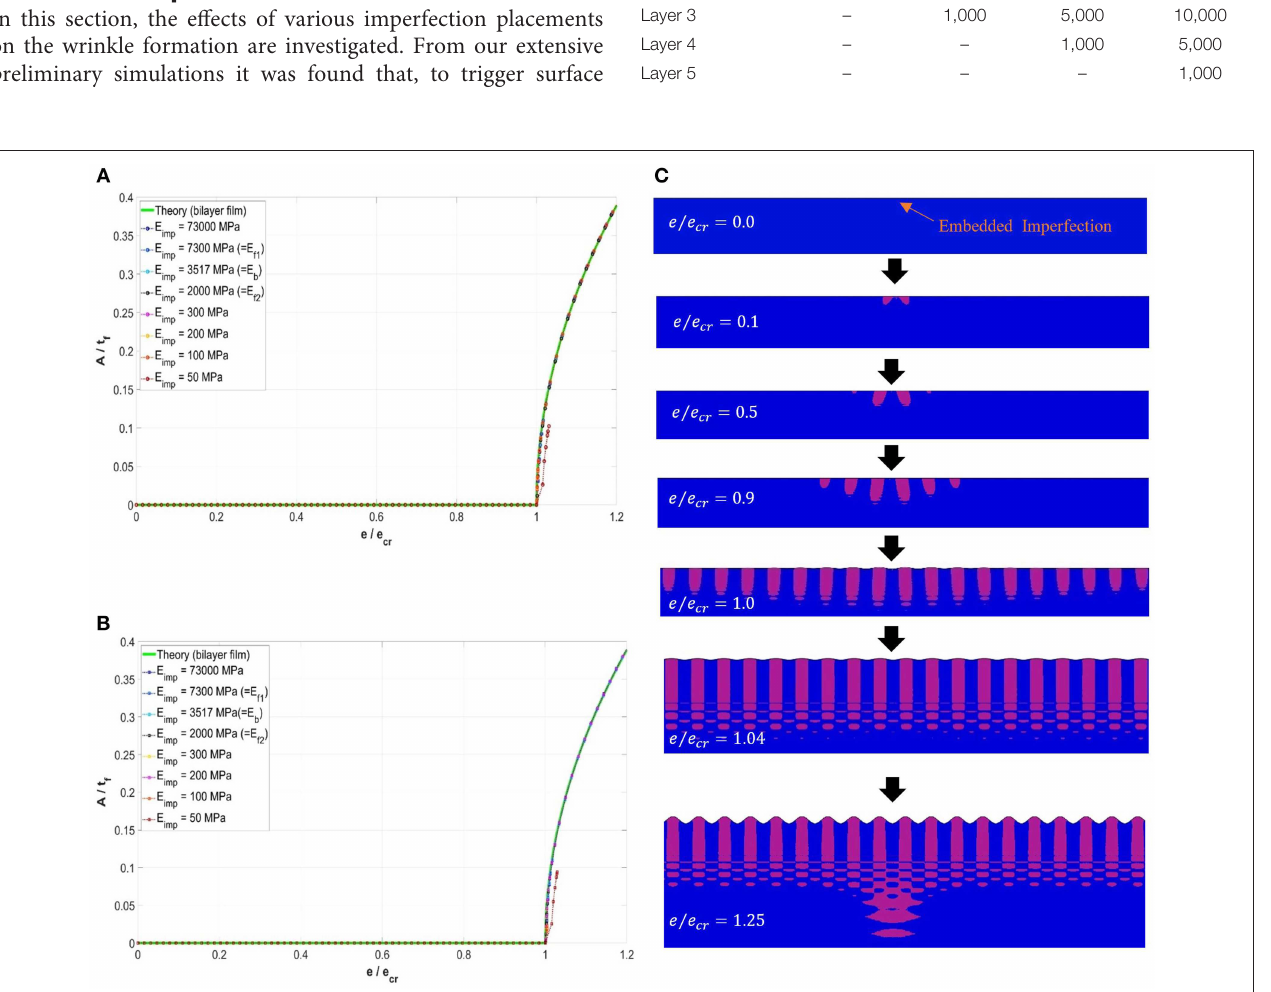
Frontiers in Materials |